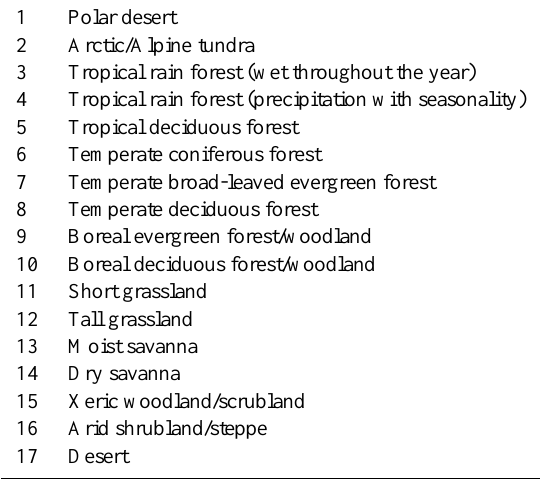
Table 1. Vegetation types in